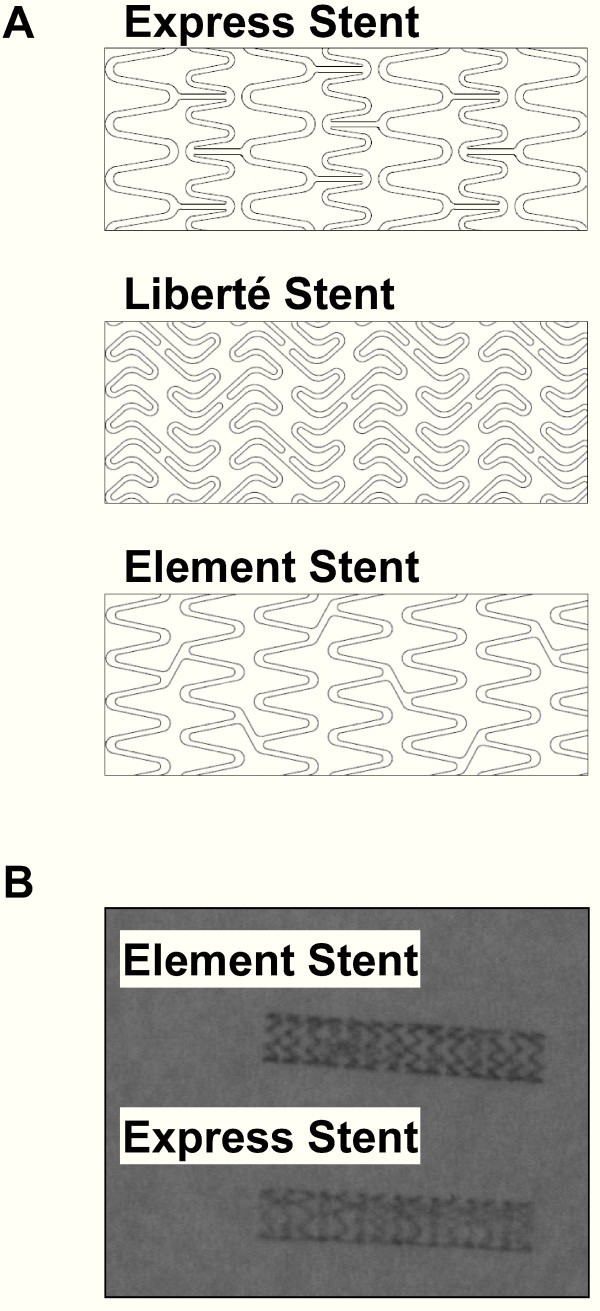
(A) Express, Liberté, and Element stent architecture; (B) Radiographic comparison of Element and Express stents. Radiographic image was generated using a General Electric OEC 9800 Digital Imaging System at operating conditions of 51 kV and 11.66 mA. No anatomical simulating phantom was used during imaging.